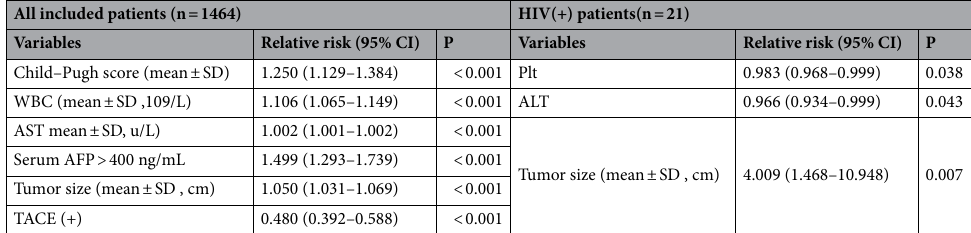
Table 2. The variables in the multivariate analysis for the BCLC-B stage. The variables of P < 0.1 in single factor analysis were included in multivariate analysis. Plt platelet, Alb albumin; AST aspartate aminotransferase; ALT alanine aminotransferase, AFP alpha-fetoprotein, WBC white blood